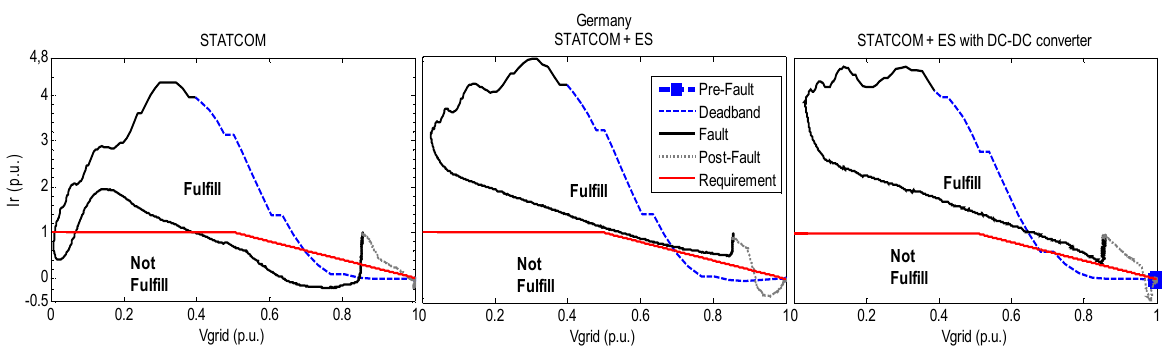
Figure 16. Reactive current evolution through the voltage dip, German case.